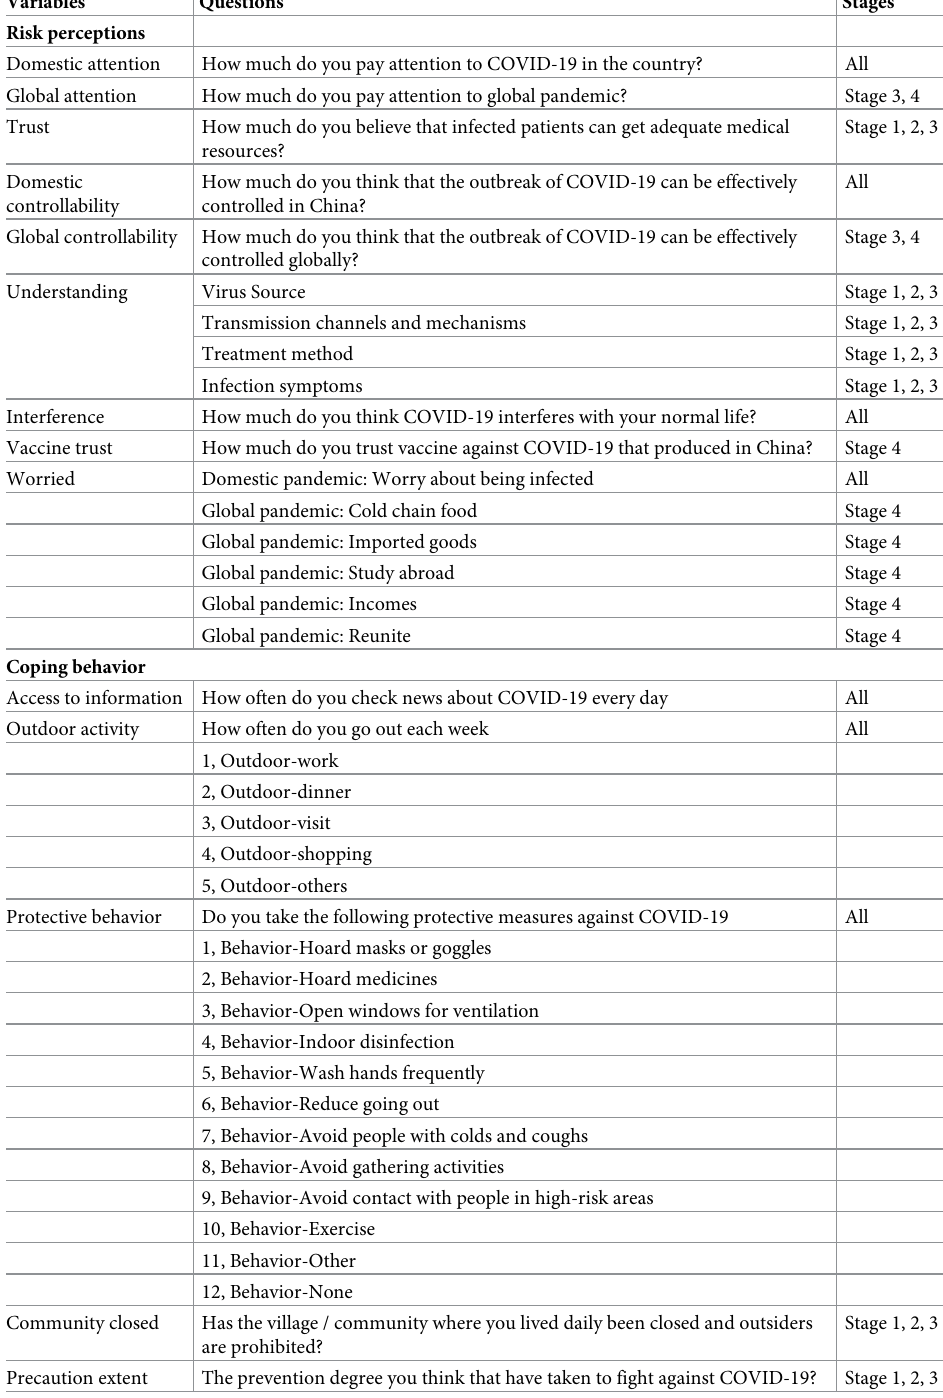
Table 1. Risk perceptions and coping behavior variables investigated at various